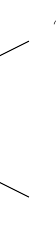
Figure 31. Feynman diagrams for DM conversion between scalar and fermion DM.